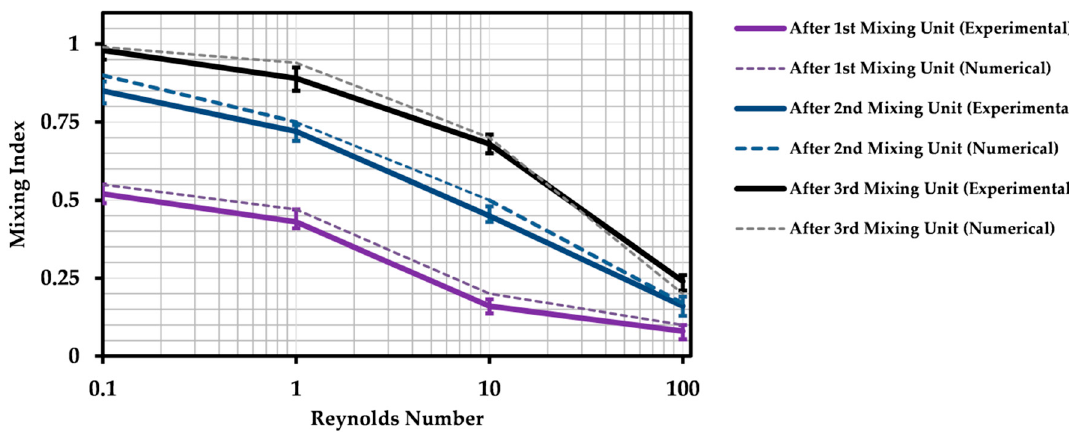
Figure 7. Variation of the experimental and numerical MI after each mixing unit versus Reynolds number (Re = 0.1, 1, 10 and 100) in logarithmic scale. Maximum MI was achieved at lower Reynolds numbers, due to more mass transport caused by molecular diffusion.